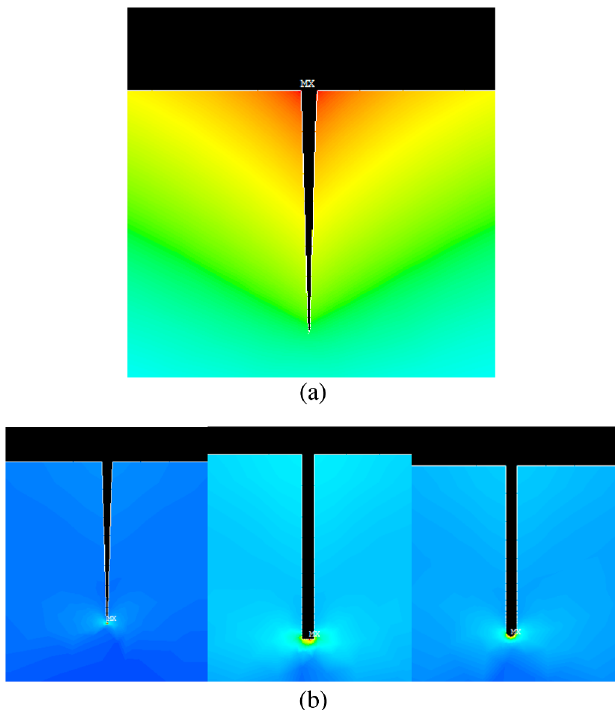
FIG. 6. Part (a) is the temperature contour plot for the trapezoid-shaped crack at 2 : 1 (cid:1) s . Part (b) is the von Mises stress contour plot for the trapezoid-shaped crack, the square-bottom crack, and the round-bottom crack at 2 : 1 (cid:1) s